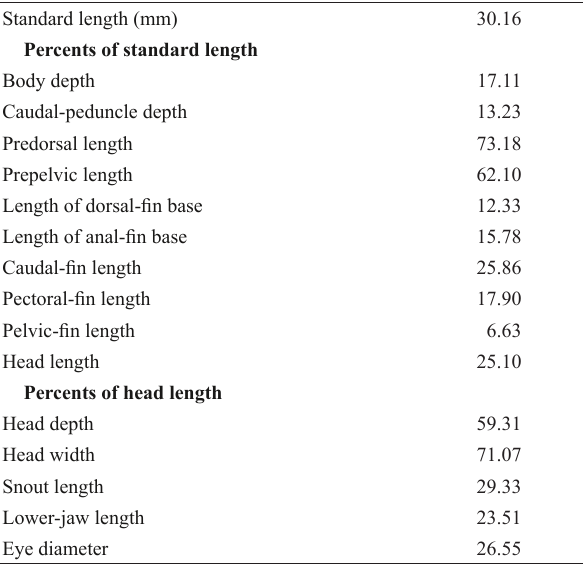
Fig. 2. Kryptolebias hermaphroditus , male (below) 30.1 mm SL, hermaphrodite (above) 35.5 mm SL, UFRN 3774, Ceará- Mirim River estuary, Extremoz, Rio Grande do Norte, Table 1. Morphometric data of the Kryptolebias hermaphroditus , male (UFRN 3774).